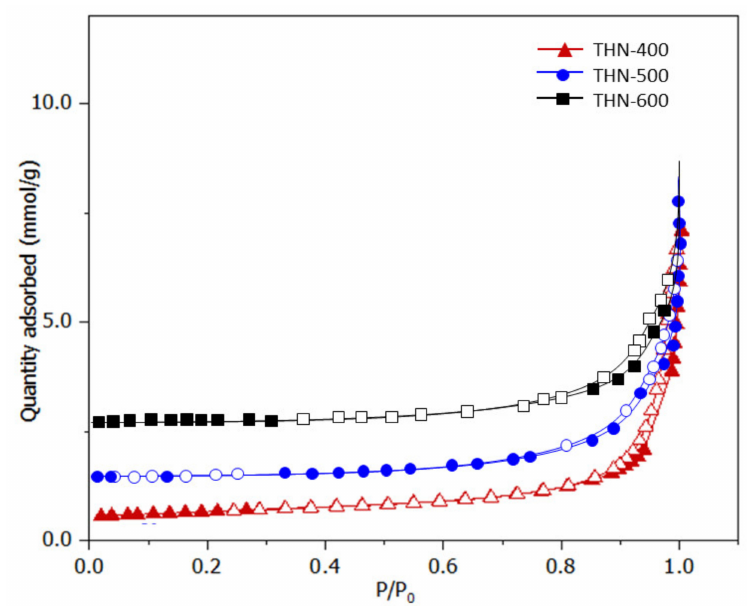
Figure 5. BET adsorption–desorption isotherms of THN.